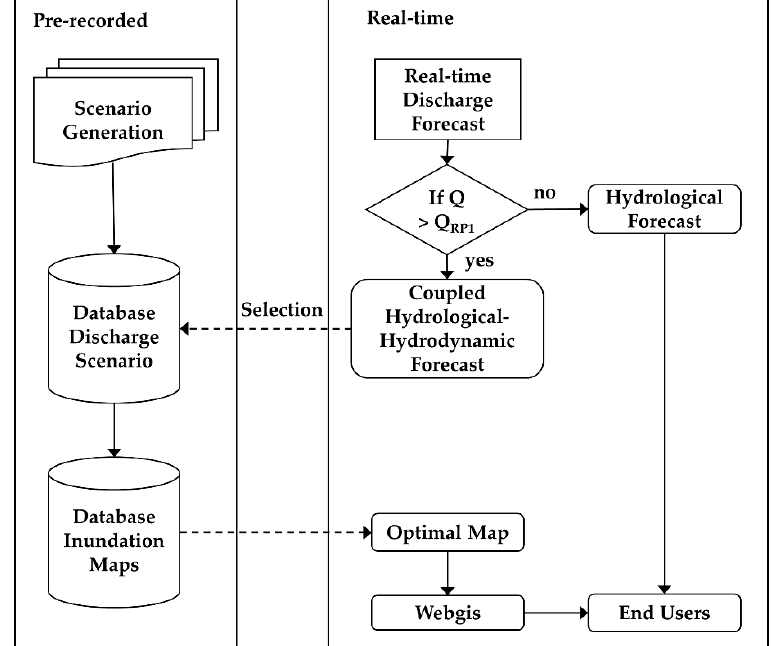
Figure 1. Framework of the offline flood inundation forecast including the pre-recorded and real time component. The coupled hydrological-hydrological forecast is activated once a one-year return period (Q RP1 ) is exceeded.